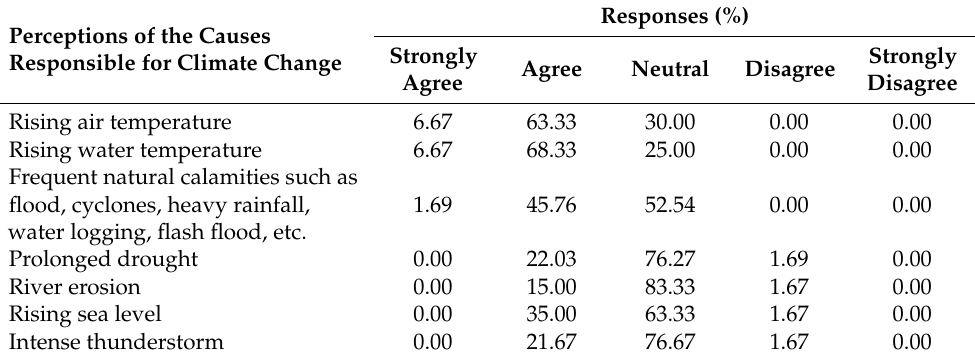
Table 2. Hatchery owners’ perceptions of climate